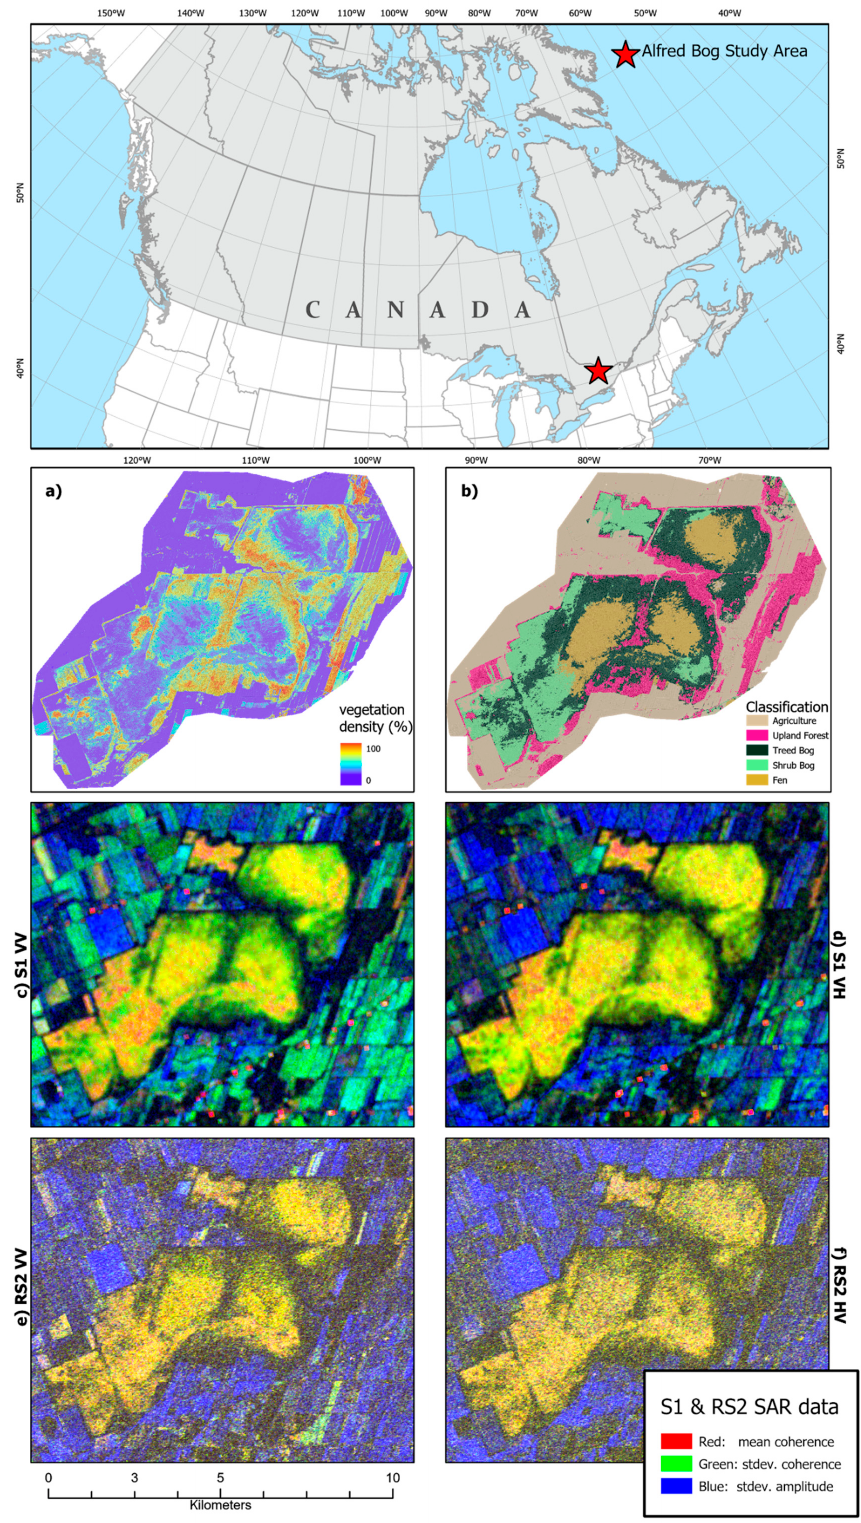
Figure 1. Map showing general location of Alfred bog within Canada (top) and insets; ( a ) vegetation density map derived from LiDAR; ( b ) classification derived from Landsat and LiDAR previous used by Millard and Richardson, 2018; and ( c ), ( d ), ( e ), ( f ) Red-Green-Blue (RGB) colour composite of coherence using Sentinel-1 and RADARSAT-2 generated from VV and VH polarization. S1, Sentinel-1; RS2, Radarsat-2.